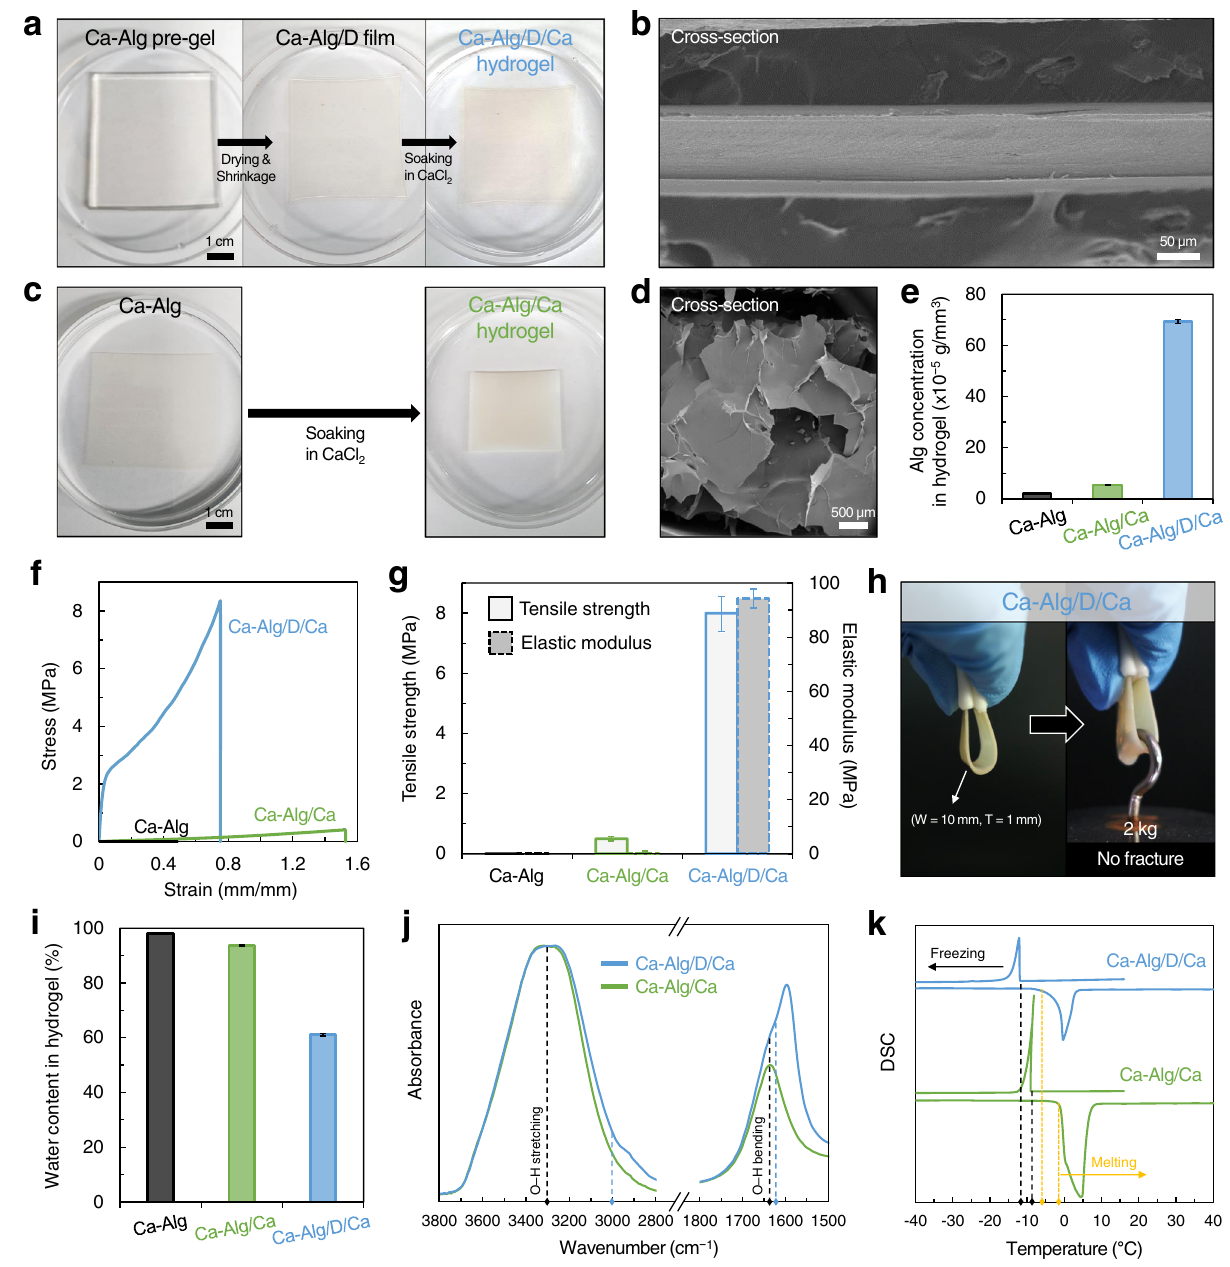
Fig. 2 Fabrication and mechanical properties of reconstructed hydrogel. a Photographs showing the hydrogel sample at each step, anisotropic drying/ shrinkage and crosslinking/rehydration. b Cross-sectional scanning electron microscope (SEM) image of the resulting reconstructed Ca – Alg/D/Ca hydrogel. c Photographs showing Ca – Alg and Ca – Alg/Ca hydrogels, respectively, before and after soaking in CaCl 2 solution. d Cross-sectional SEM image of Ca – Alg/Ca hydrogel. e Alginate concentration in each hydrogel. f Stress – strain curve and g tensile strength and elastic modulus of Ca – Alg, Ca – Alg/Ca, and Ca – Alg/D/Ca hydrogels. h Photographs representing the mechanical robustness of Ca – Alg/D/Ca hydrogel. i Water content in each hydrogel. j Fourier-transform infrared (FTIR) spectra and k Differential scanning calorimetry (DSC) curves of Ca – Alg/Ca and Ca – Alg/D/Ca hydrogels, exhibiting differences of interaction degrees between the sparse and densi fi ed polymer networks. SEM images were obtained after lyophilization. Error bars correspond to standard